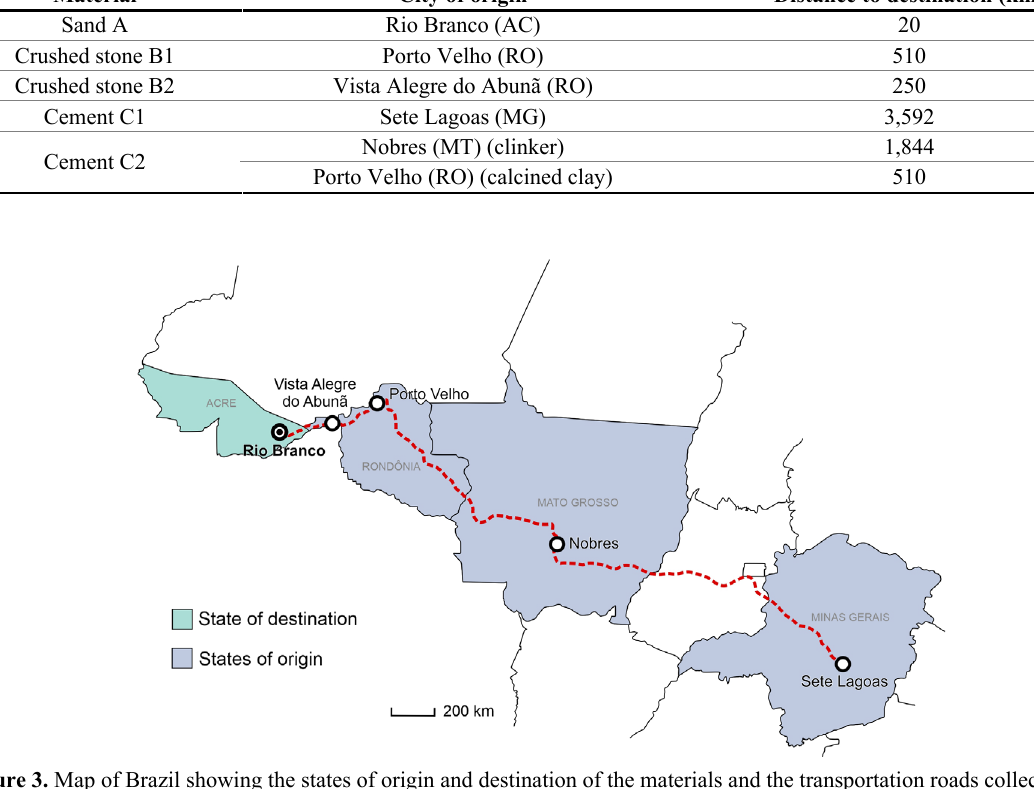
Figure 3. Map of Brazil showing the states of origin and destination of the materials and the transportation roads collected using GoogleMaps